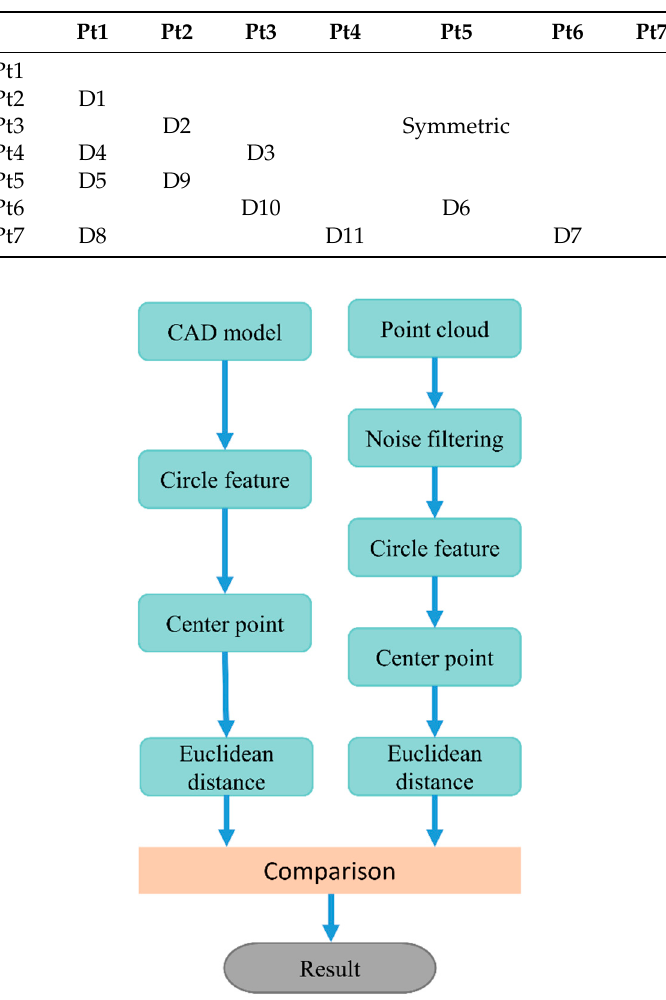
Table 6. Configuration of feature points and feature distance.